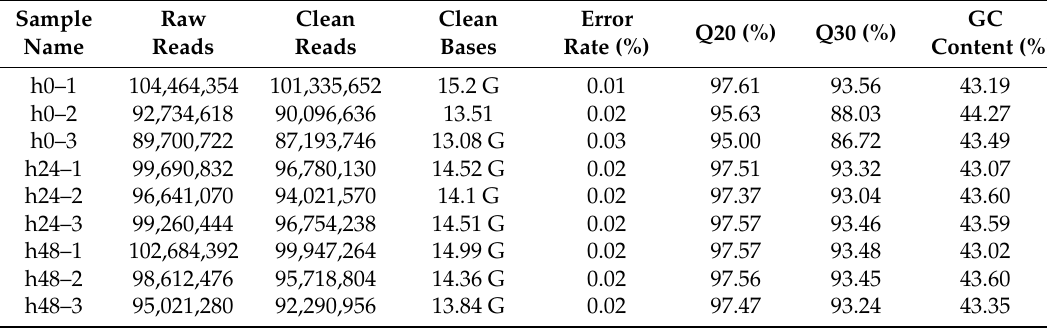
Table 1. Sequencing data for nine libraries obtained by RNA